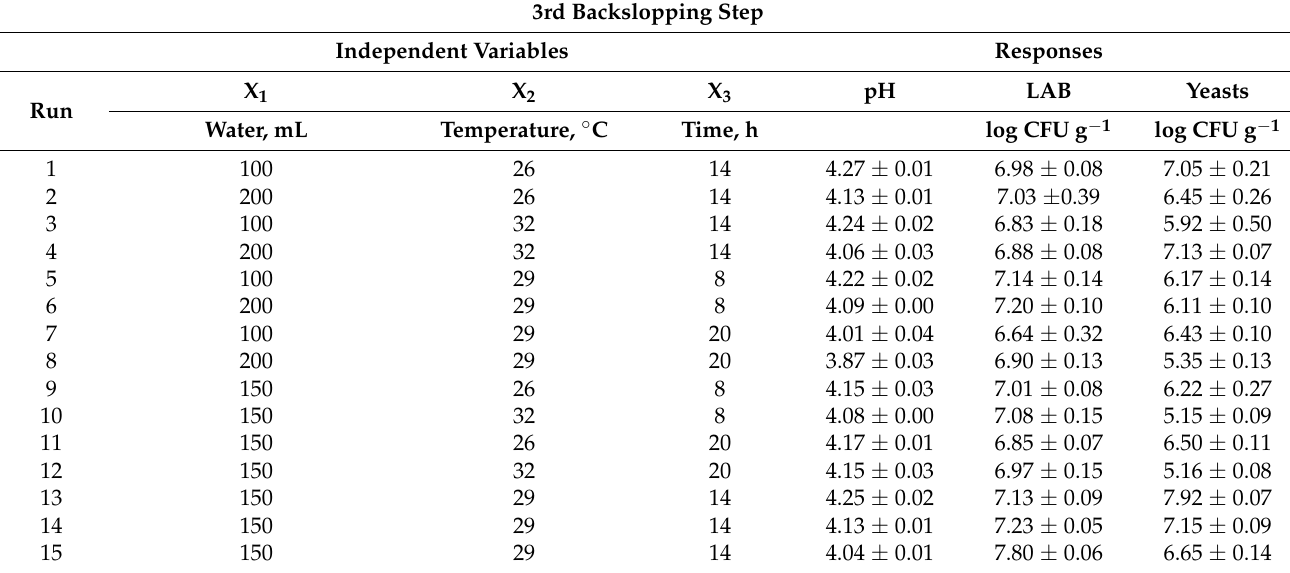
Table 5. The Box–Behnken experimental design and responses in the 3rd backslopping step of fermentation.